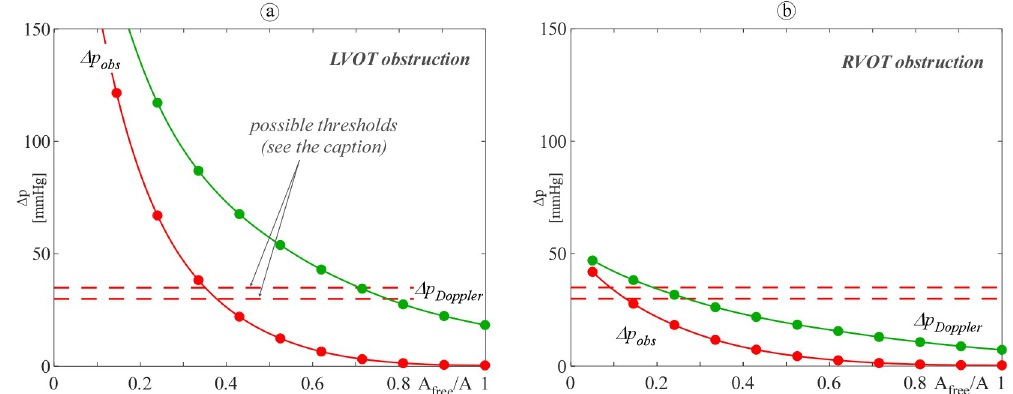
Fig 9. Computed mean pressure gradient with (red filled dotted line, Δ p the pressure recovery effect for (a) LVOT and (b) RVOT. Red dashed lines depict possible mean gradient thresholds for moderate/severe obstruction, inferred from the literature for the case of a tumoral obstructive condition as it follows: 30 mmHg [32] and 35 mmHg [31].